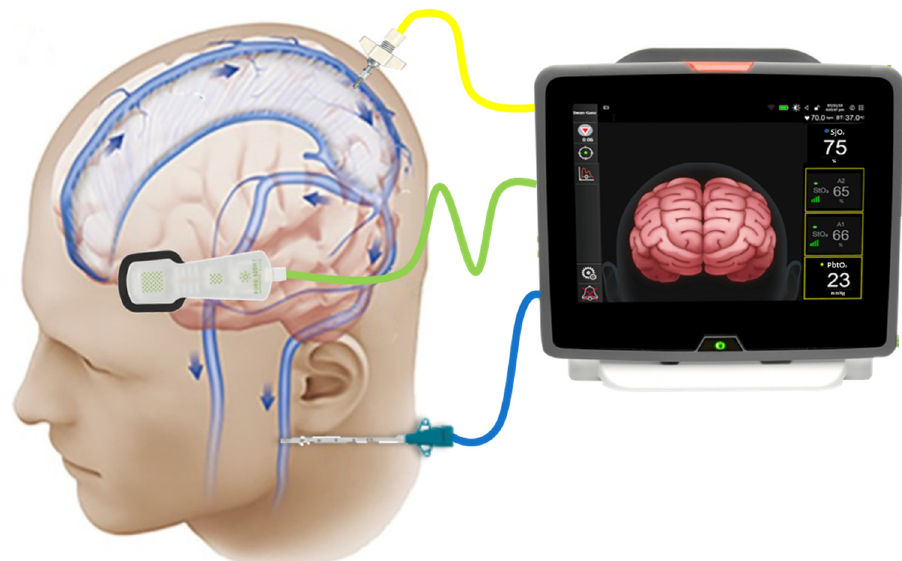
Figure 7. NIRS-derived regional tissue oxygen saturation (green probe) analyzes the oxygen concentration in cerebral microcirculation, which is predominantly from venous oxygenation. Jugular bulb venous saturation (blue probe) analyzes the remaining oxygen concentration that flows from the venous sinuses to the internal jugular vein. Both are indirect measurements of how much oxygen is being used by the brain. Brain tissue oxygenation tension (yellow probe) analyzes the dissolved oxygen within the cerebral plasma that diffuses across the blood brain barrier (BBB). (Figure modified from [57,58]).